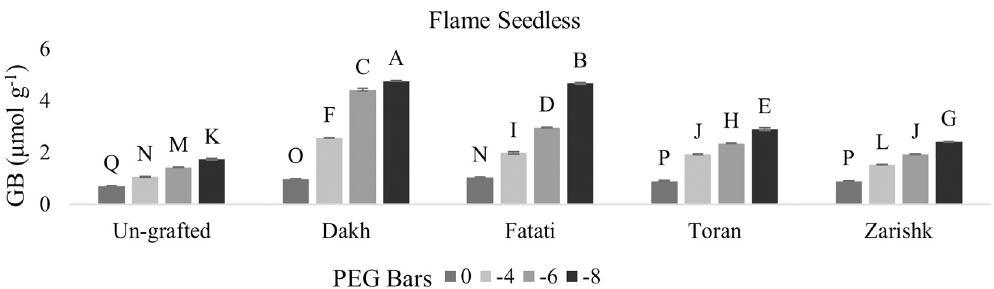
Fig 8. Glycine betaine content (GB) of un-grafted and grafted Flame Seedless scion variety on different wild grapevines under drought stress condition. Data is represented as mean SD and letters showed significant difference at p < 0.05.